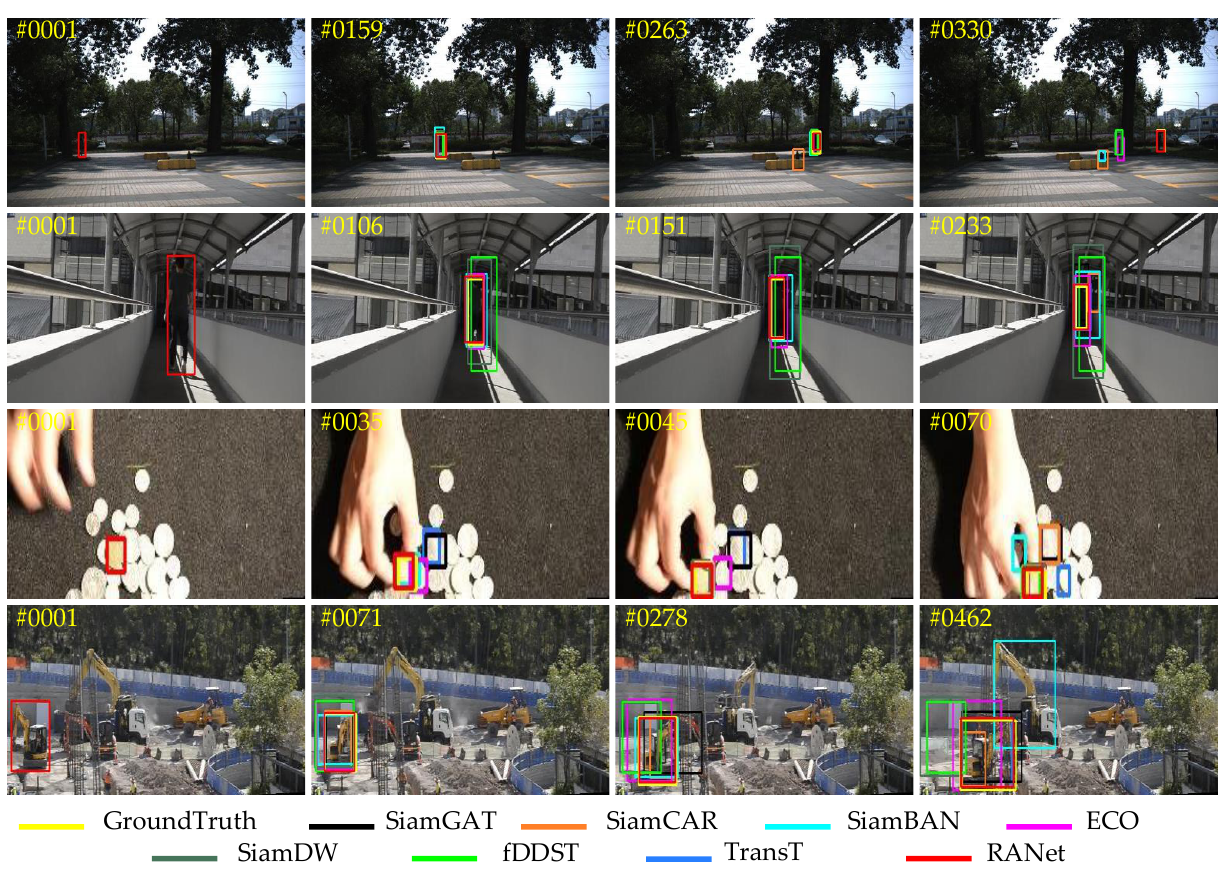
Figure 10. Qualitative comparison of 8 trackers and groundtruth on some videos in some challenging scenarios. Among them, the tracking result of RANet is marked with the red box, and the groundtruth is marked with the yellow box. The video name from top to bottom are Pedestrian2, Student, Coin, and